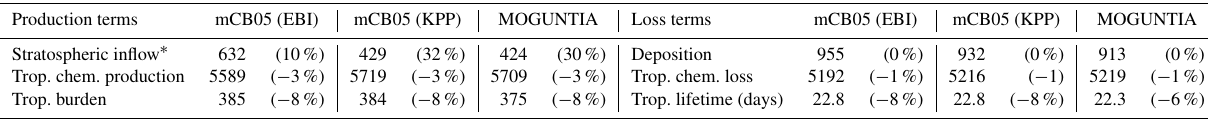
Table 4. Tropospheric budgets and burden (Tg(O 3 )) of O 3 for the year 2006 (Tg(O 3 )yr − 1 ) using the 150ppb O 3 mixing ratio to define the tropopause level. In parentheses, the relative differences using the 100ppb O 3 mixing ratios are also presented, calculated with reference to the 150ppb O 3 tropopause level